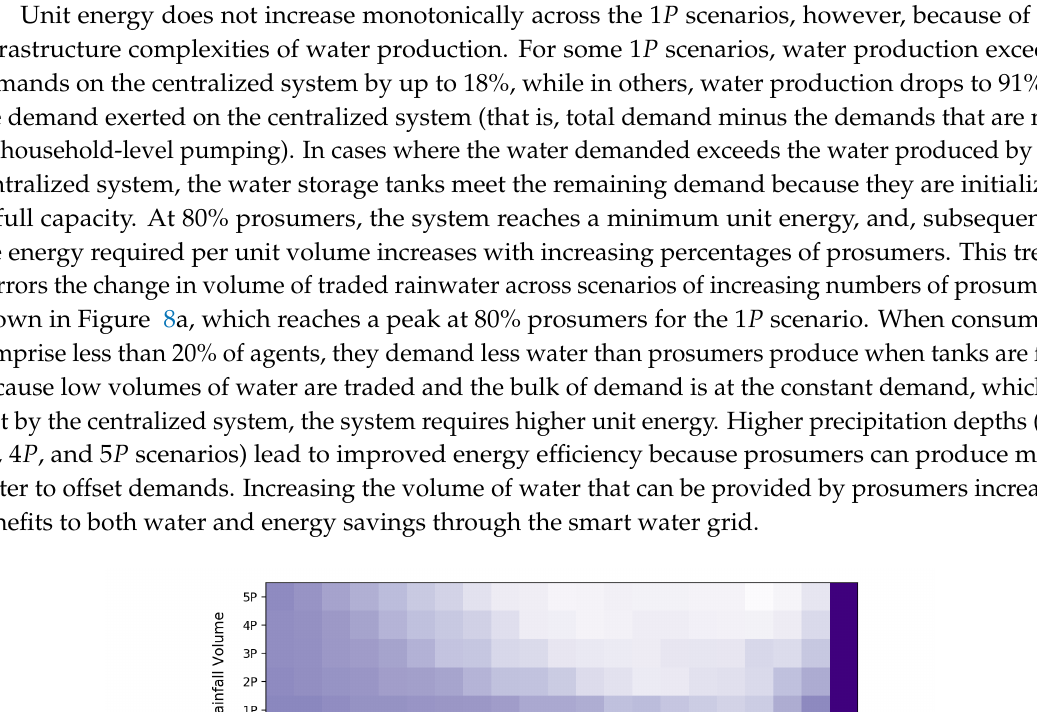
Figure 9b,c. Household-level pumps inject water in the network at peak demand times, which offsets the need to use the additional pumps that operate in parallel to the main pump. As a result, the number of pumps that operate to provide water from the centralized system decreases with increasing numbers of prosumers (nine pumps are needed for 0–5% prosumers; seven pumps: 10–15%; six pumps: 20–25%;